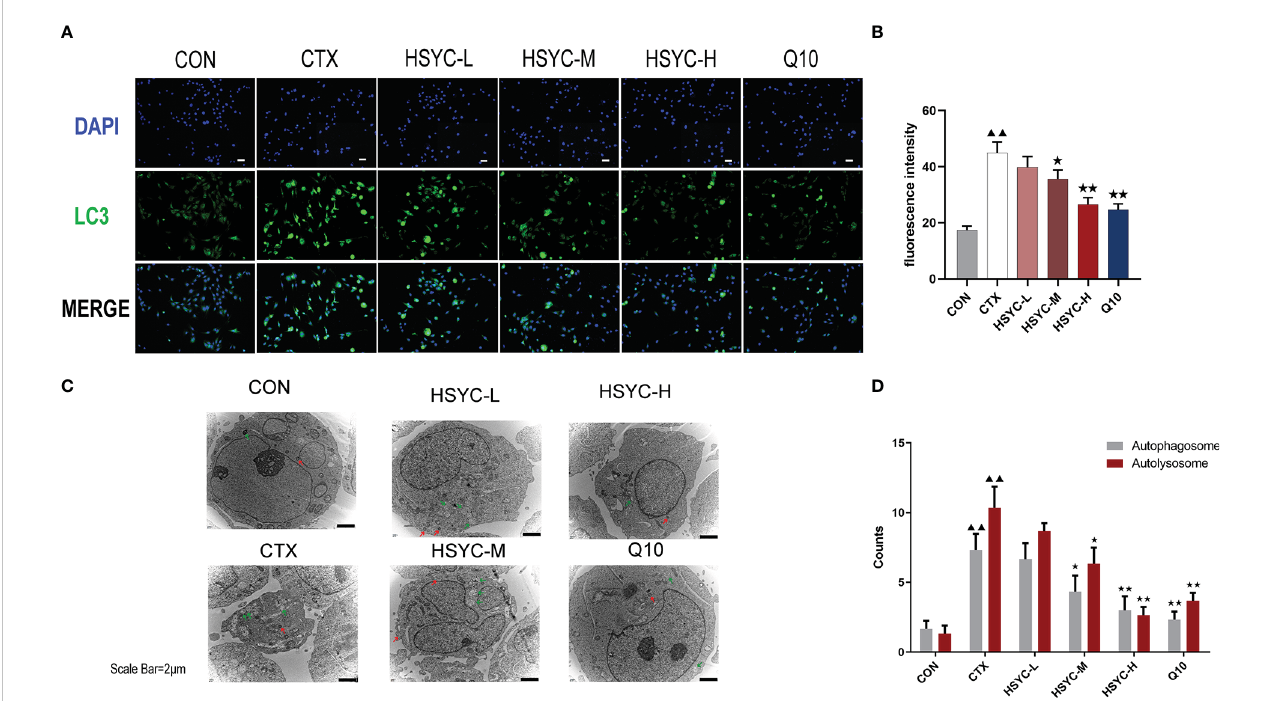
FIGURE 5 HSYC improved autophagy in GCs of POI af fl icted mice. (A, B) Immuno fl uorescence images of the LC3. Green color represents the LC3 and blue represents nucleus of granulosa cells. Scale bar: 25 m m. The result is shown using histogram plots means with SDs represent LC3 fl uorescent intensity levels. (C, D) . Observation of autophagosomes and autophagolysosomes in granulosa cells of different groups under transmission electron microscopy. Scale bar:2 m m. The result is shown using histogram plots means with SDs represent autophagosome and autophagolysosome counts. Histogram elements represent the mean ± SD (n=3). ▲▲ presents P < 0.01 compared to the CON group; ★ presents P < 0.05 compared to the CTX group; ★★ presents P < 0.01 compared to the CTX